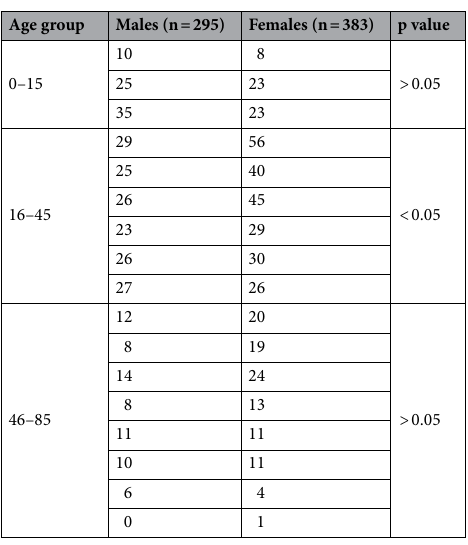
Table 1. Gender disparity between male and female in different age